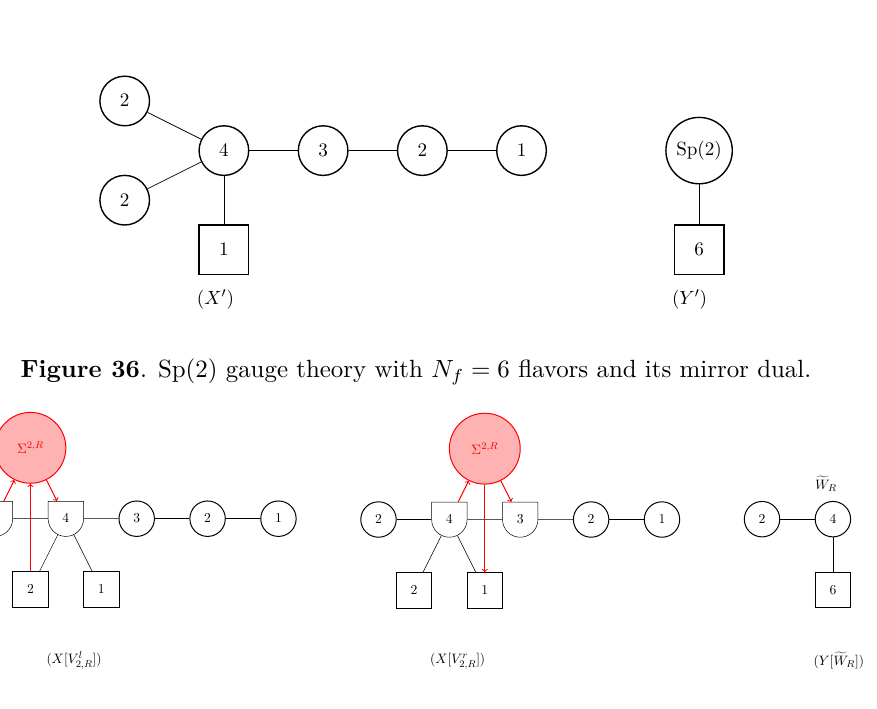
Figure 37 . The vortex defect V 2 ,R , realized by the deformation of two different 3d-1d quivers — ] and X [ V r ] . The dual quiver is Y [ f W X [ V l 2 ,R 2 ,R